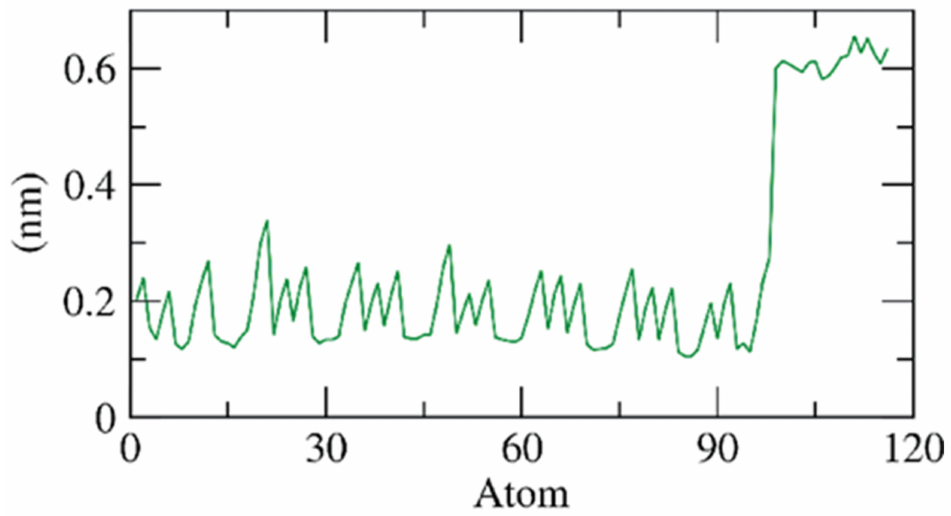
Figure 8. RMSF of β CD-anabasine